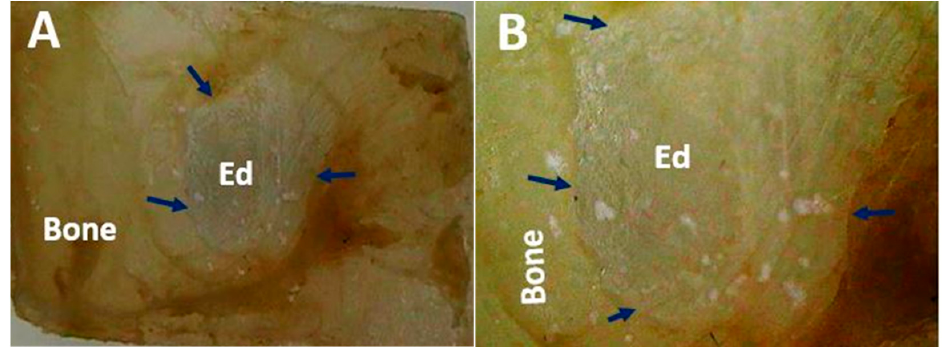
Figure 3. Cranial implantation area of the empty defect. ( A ): Preparation at 1×. ( B ): Preparation at 3×. Blue arrows: soft tissue covering. Stereoscopic microscope technique.